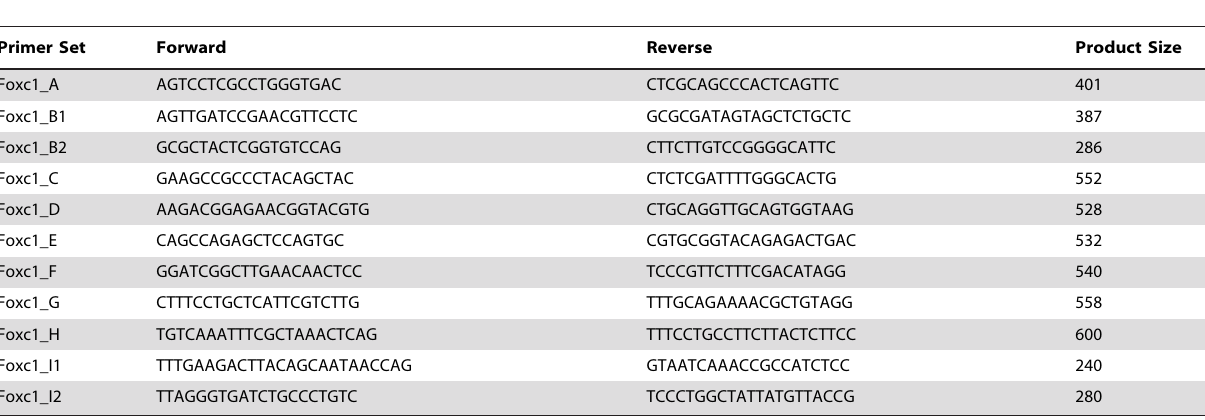
Table 3. Primers used for sequencing mouse Foxc 1.